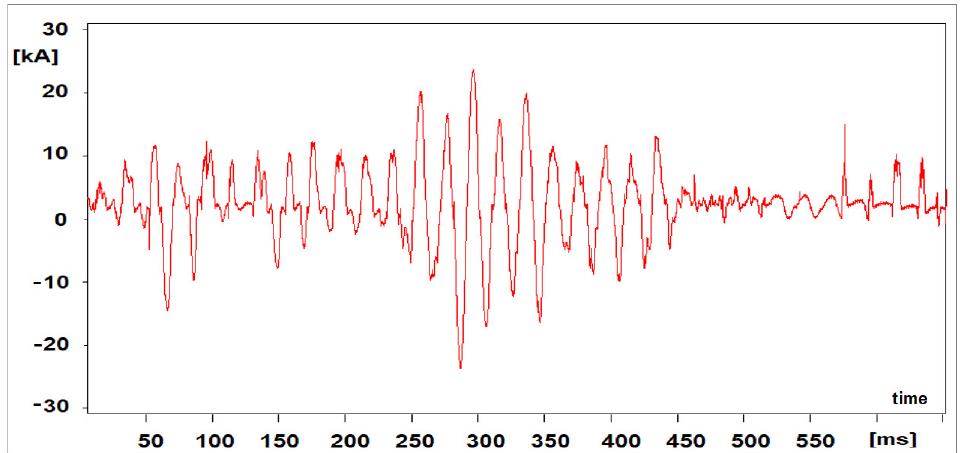
Figure 3. The oscillogram of the arc current in the initial phase of melting the scrap.